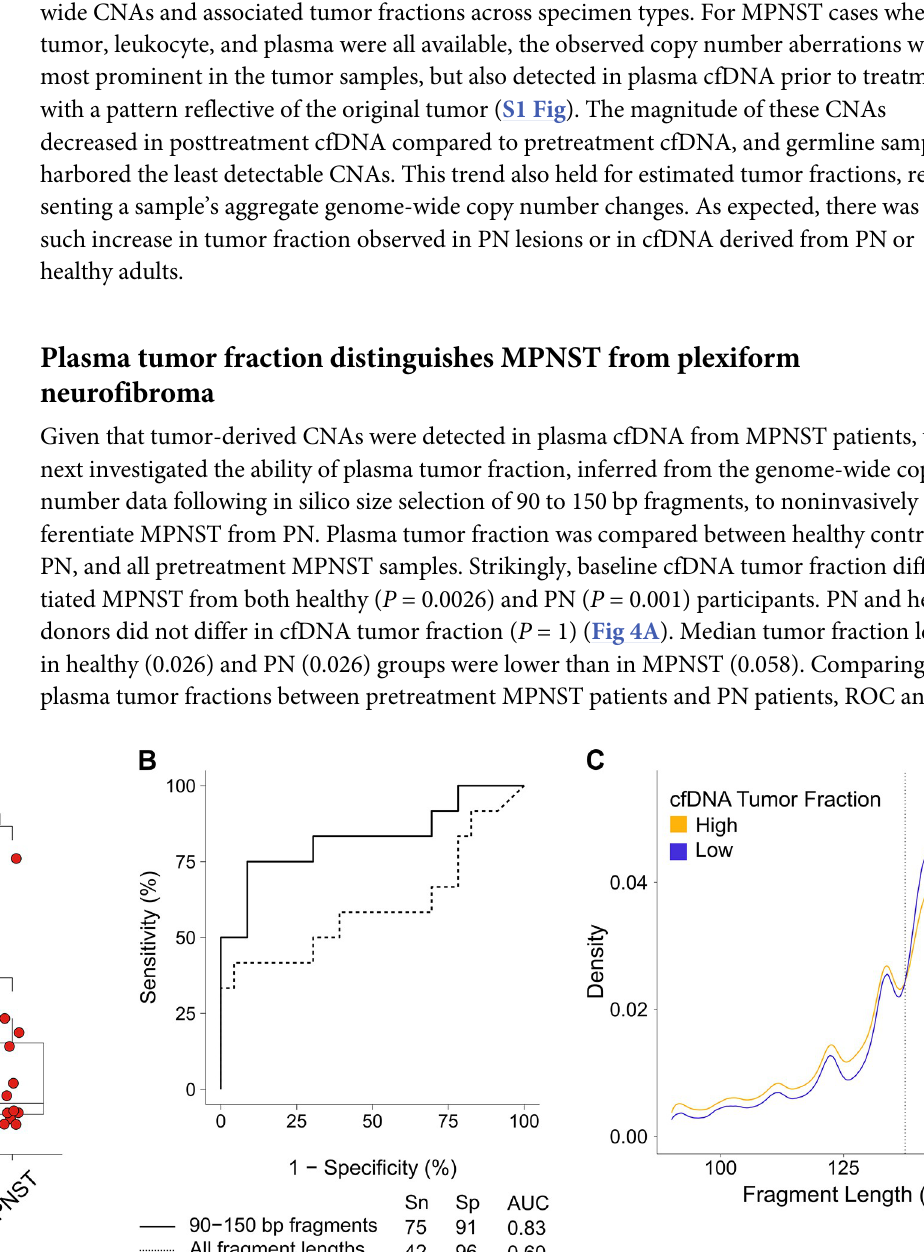
PLOS Medicine| https://doi.org/10.1371/journal.pmed.1003734 August 31,